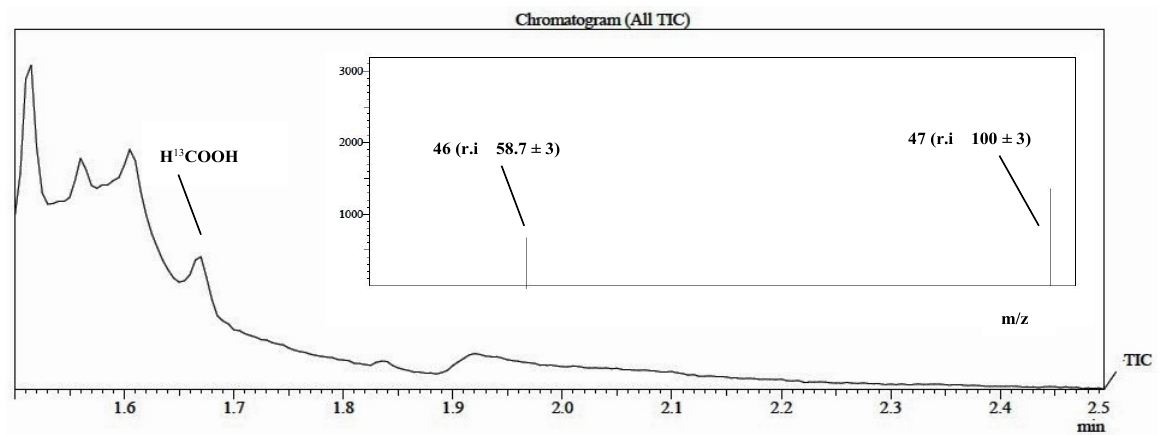
Figure 3 . Qualitative determination of formic acid performed by GC/MS in SIM Mode analyzing formic acid- 13 C obtained by photoreduction of NaHCO 313 C labelled. analyzing an authentic sample of formic acid- 13 C 95 wt. % in H 2 O, 99 atom % 13 C.